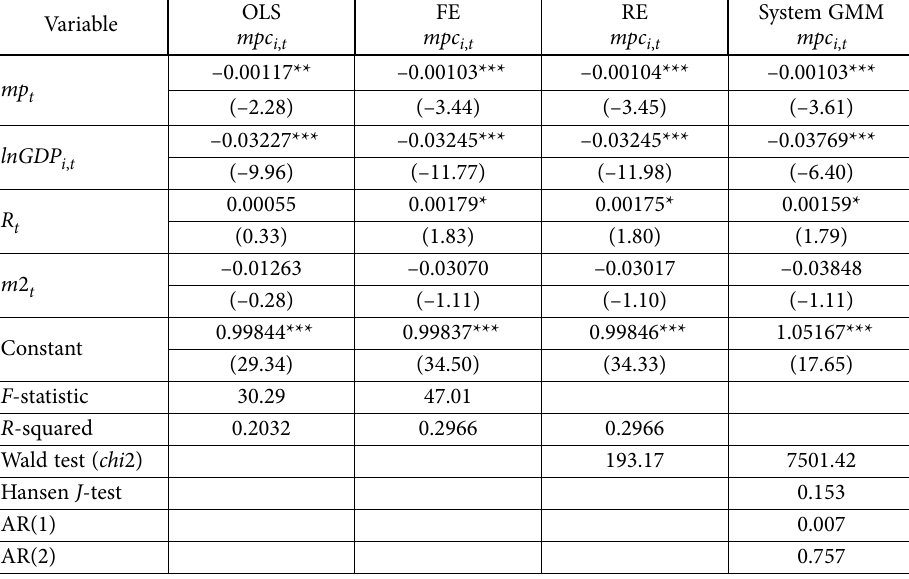
Table 4. The direct impact of macroprudential policies on consumption